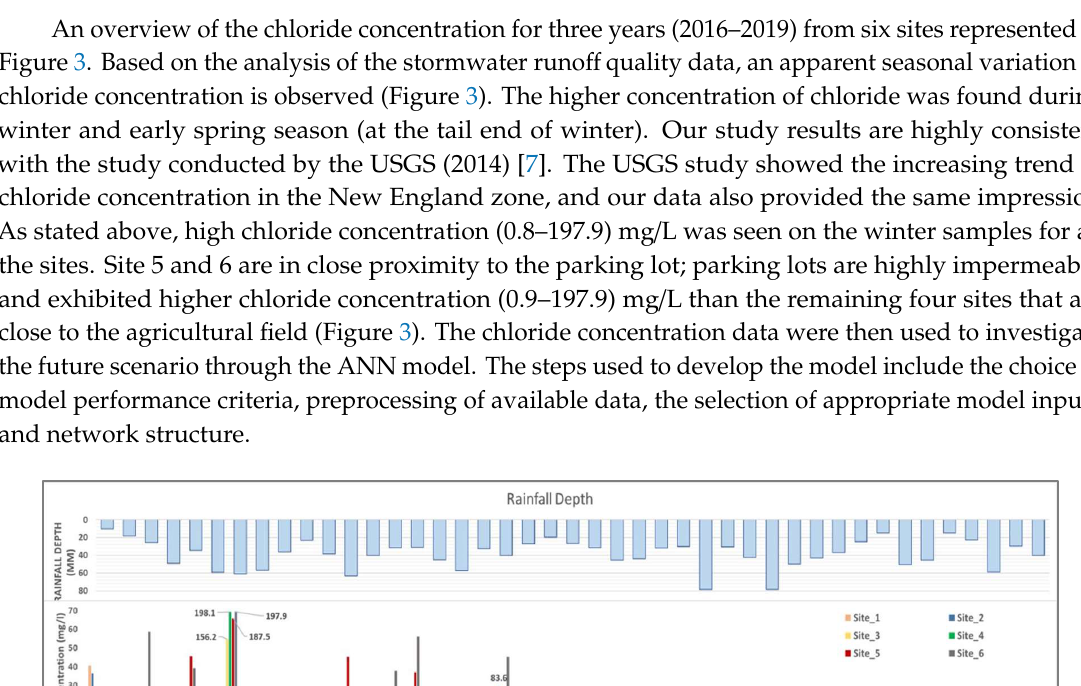
ff are shown, from 2016 to